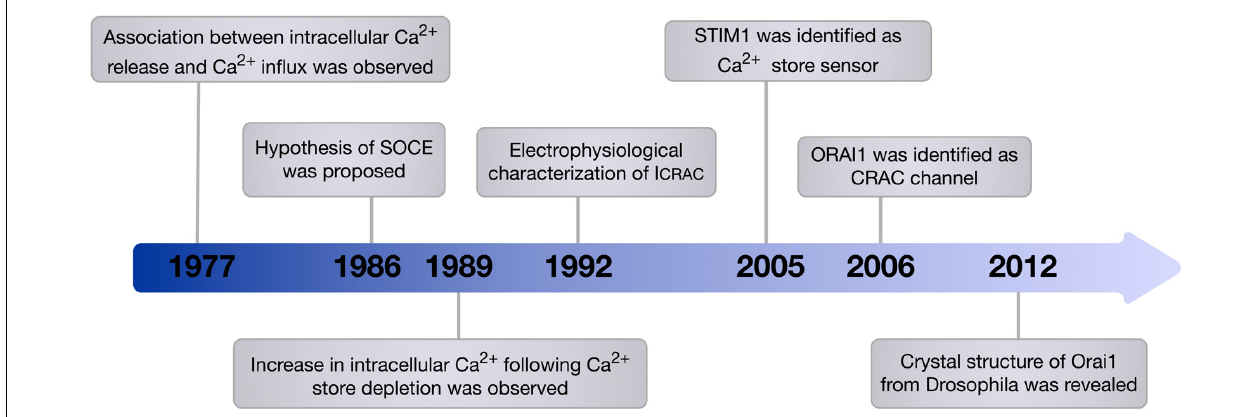
FIGURE 1 | Timeline of the main milestones in the discovery of SOCE. In 1986, Putney proposed the hypothesis of SOCE. This hypothesis was then verified and the components of SOCE, which are STIM1 the Ca 2 + store sensor and ORAI1 the de facto pore-forming subunit of CRAC channel, were identified. Since this discovery, the involvement of ORAI1 in various vital cellular processes and its contribution to diverse diseases have been